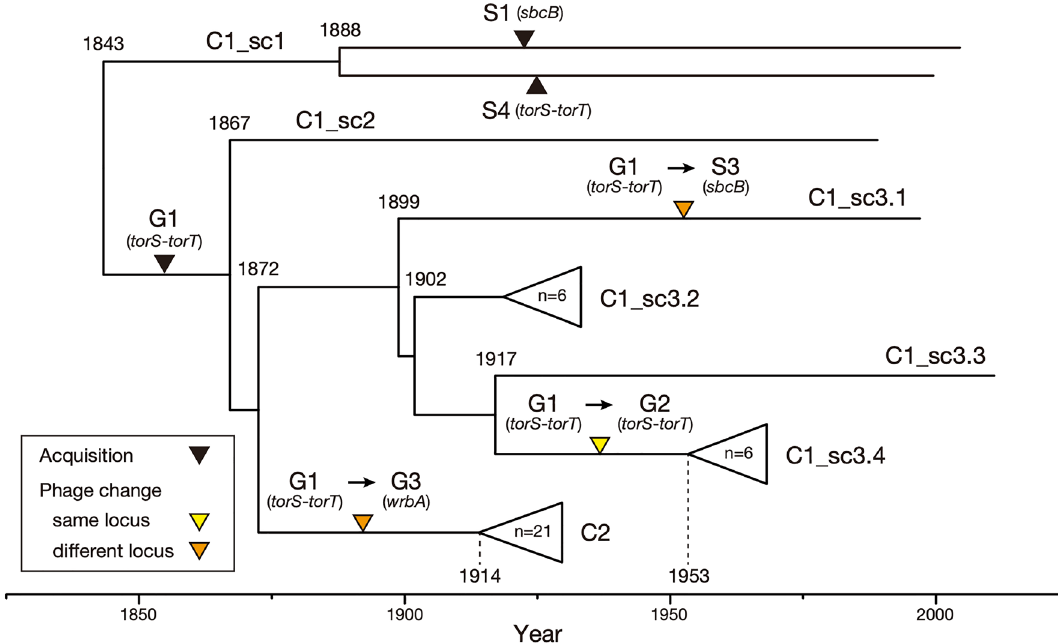
Figure 3. Timeline of the acquisitions and changes of Stx1a phages throughout the evolution of ST21. The estimated timing of acquisitions and changes to Stx1a phages are indicated by coloured triangles in a maximum clade credibility tree of ST21 strains. Tips, branches and internal nodes in C1_sc3.2, C1_sc3.4, and C2 are brought together under open triangles. A C2 strain (DB02) lacking temporal information was not included in this tree. The complete topology of the tree is shown in Supplementary Figure